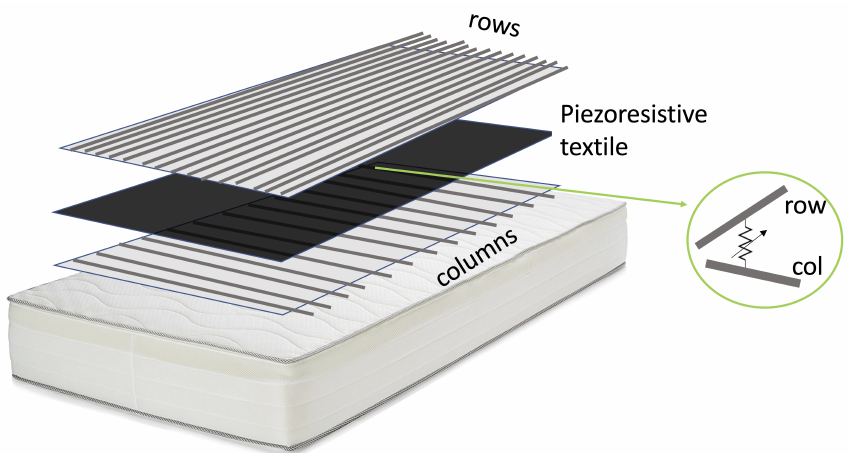
Figure 1. The principle of the pressure mapping layer (PML) prototype: a three-layer structure implementing a piezoresistive array of 13 × 15 elements. The sensing areas are represented by each crossing between a row and column conductors, as shown in the figure insert.